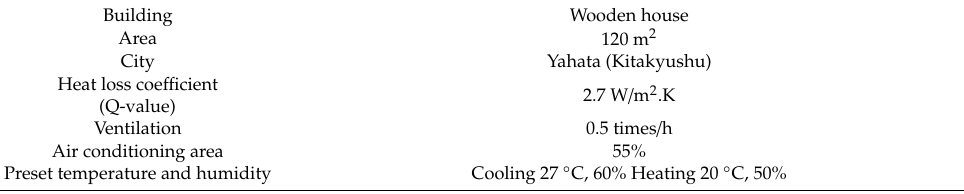
Table 3. Calculation